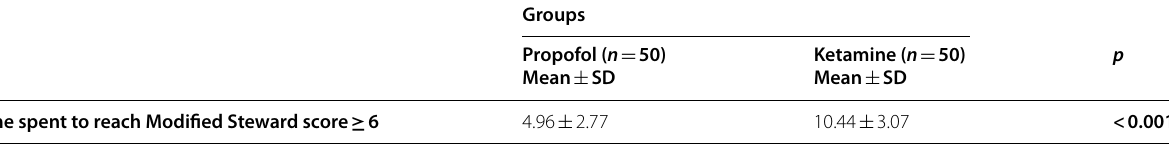
Table 5 Time comparison (in minutes) to reach Modified Steward score